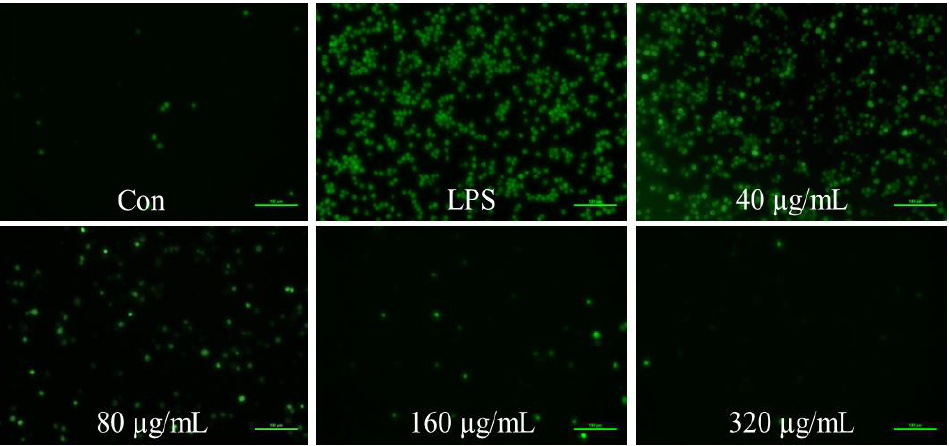
Figure 2. Observation of cellular ROS by fluorescence inverted microscope.